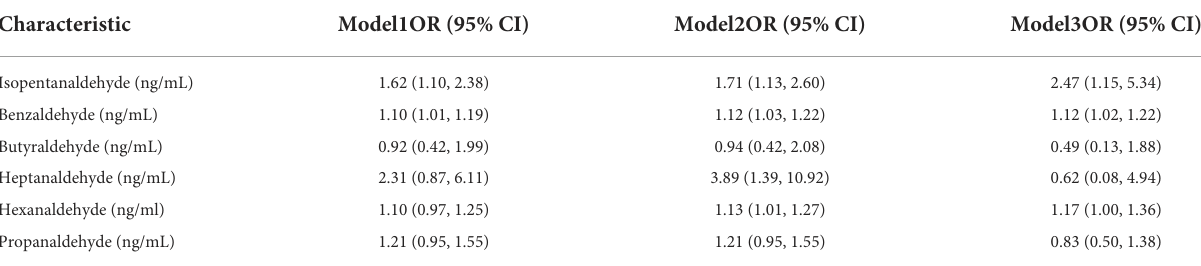
TABLE 2 Logistic regression analysis aldehydes exposure and kidney stones